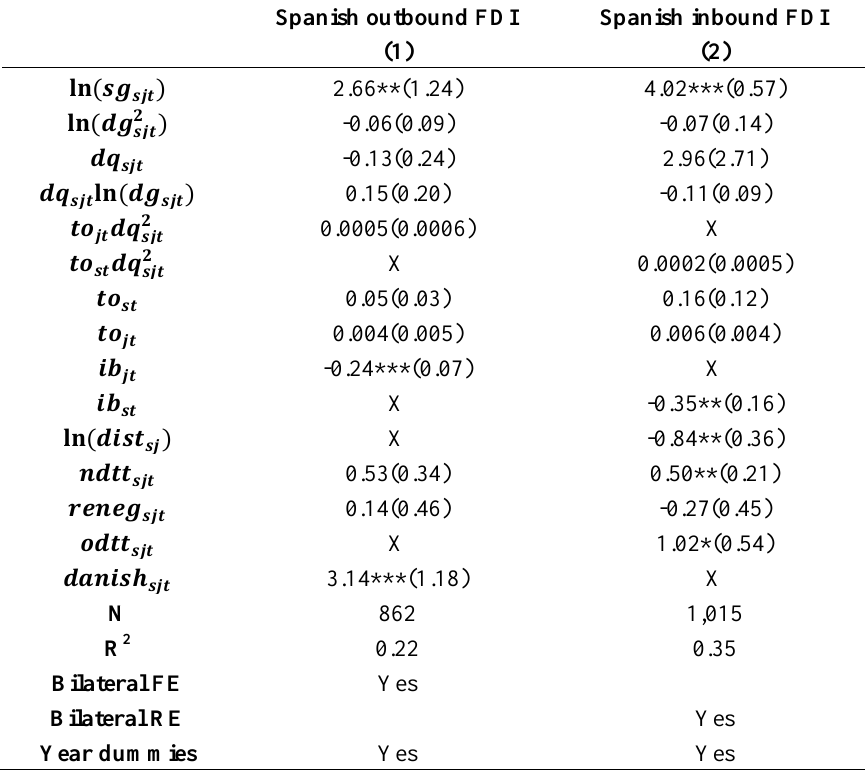
Table 3 : Effect of DTTs on Spanish inbound and outbound FDI: Types of DTTs Spanish outbound